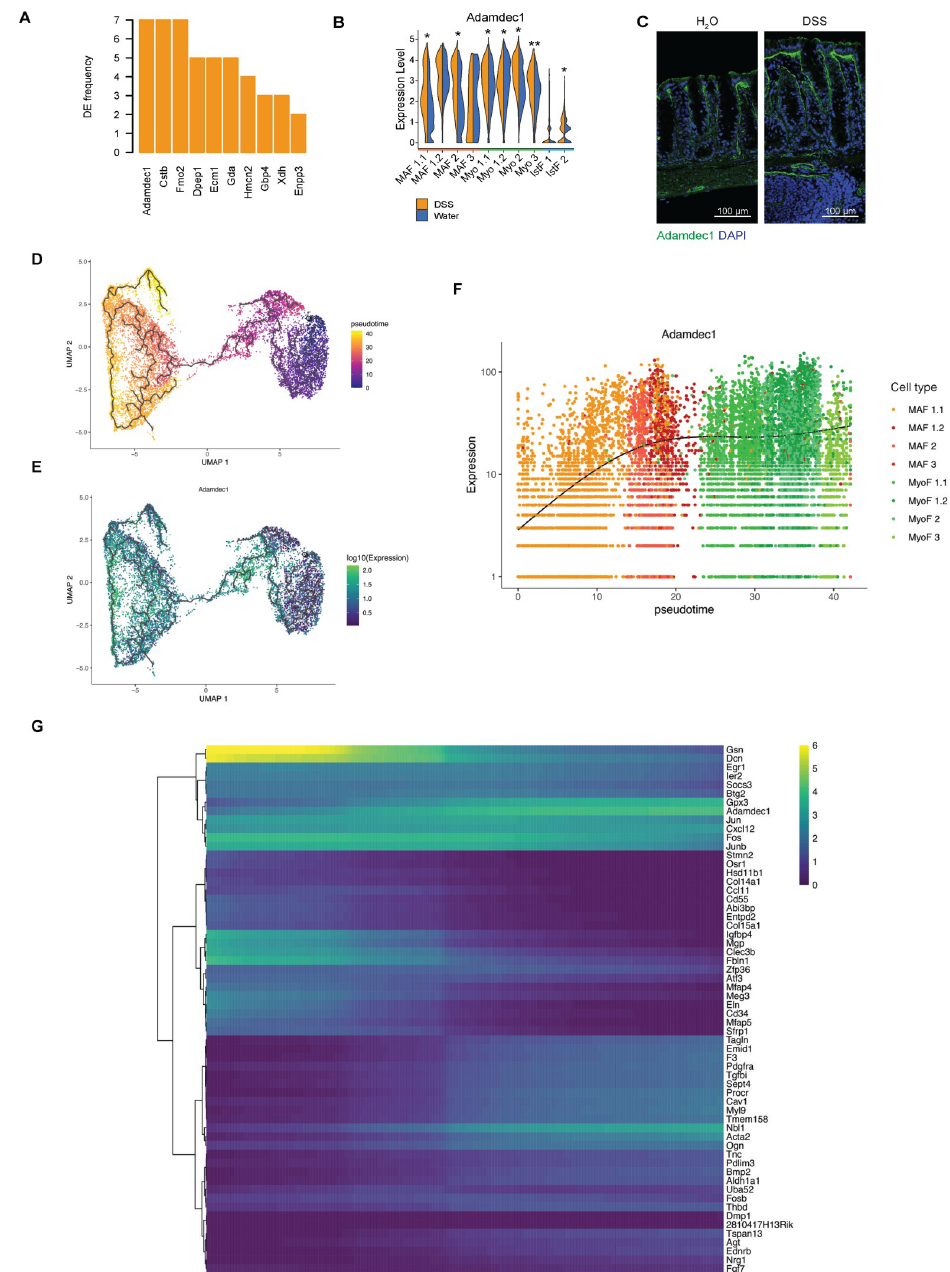
Fig 5. The myofibroblast differentiation program confers matrix remodeling function. (A) Genes that are most often differentially expressed in all stromal clusters between water- and DSS-treated samples and whose expression is enriched in gastrointestinal tissues. The frequency of times they are a DEG is plotted on the y-axis. (B) Violin plot of Adamdec1 across fibroblast clusters in water- and DSS-treated samples. Normalized gene expression levels are plotted on the y-axis. Significant DEGs had FDR < 0.05, and respective adjusted p -values derived using MAST (see Methods); � p < 0.05, �� p < 0.001, ��� p < 1E-10. (C) IF staining of colon from water- and chronic DSS-treated mice. Adamdec1 (green), DAPI (blue). Scale bar, 100 μ m. n = 3. (D) Inferred differentiation trajectory for MAFs into myofibroblast subset populations. Each dot represents a cell, and color represents the estimated pseudotime for each cell. (E) Adamdec1 expression overlaid on top of inferred differentiation trajectory for MAF into myofibroblast subset populations. Each dot represents a cell, and color represents Adamdec1 expression. (F) Dynamics of Adamdec1 expression levels as a function of pseudotime. Each dot represents a cell, and color represents the annotated fibroblast subset. (G) Genes identified in association with MAF-to-myofibroblast inferred differentiation trajectory. Color indicates when gene expression peaks along differentiation trajectory along the x-axis (from left to right).